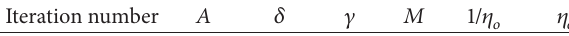
Table 2: Optimization results of flat plate film cooling. Iteration